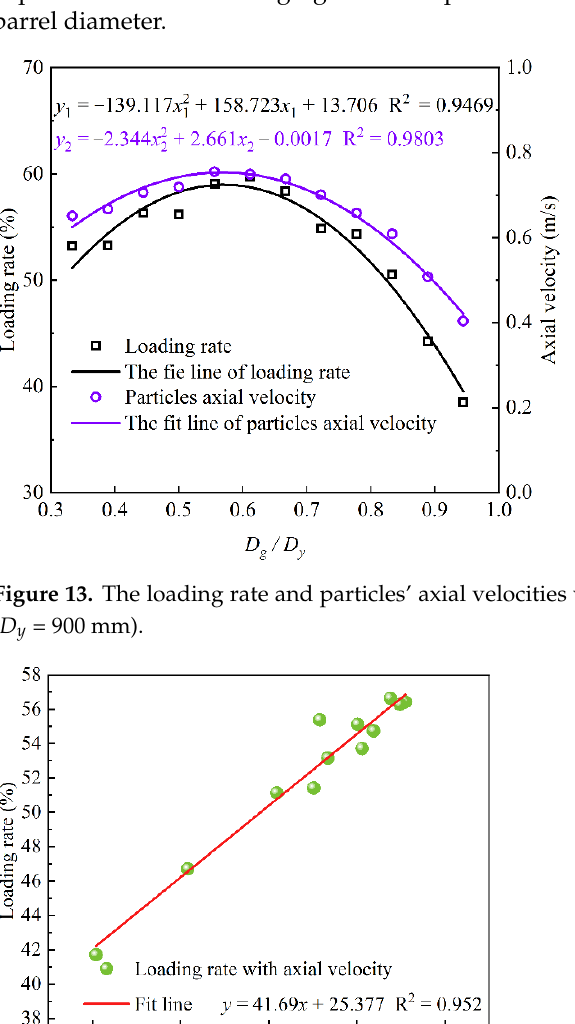
Figure 14. Particles’ axial velocities versus loading rate.